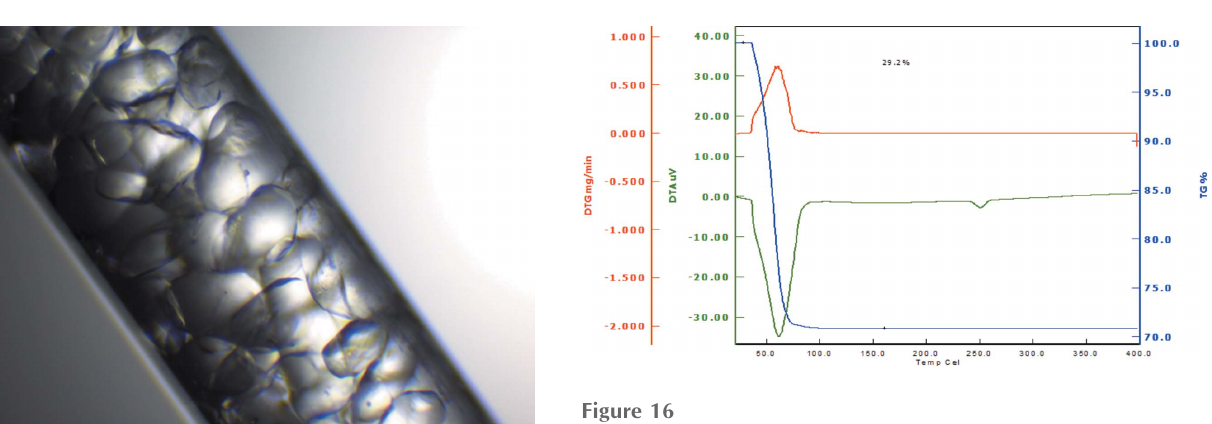
Figure 16 Thermal analysis of LiNa 3 (SO 4 ) 2 (cid:2) 6H 2 O. Heating rate: 5 K min (cid:5) 1 ; N 2 purge: 300 ml min (cid:5) 1